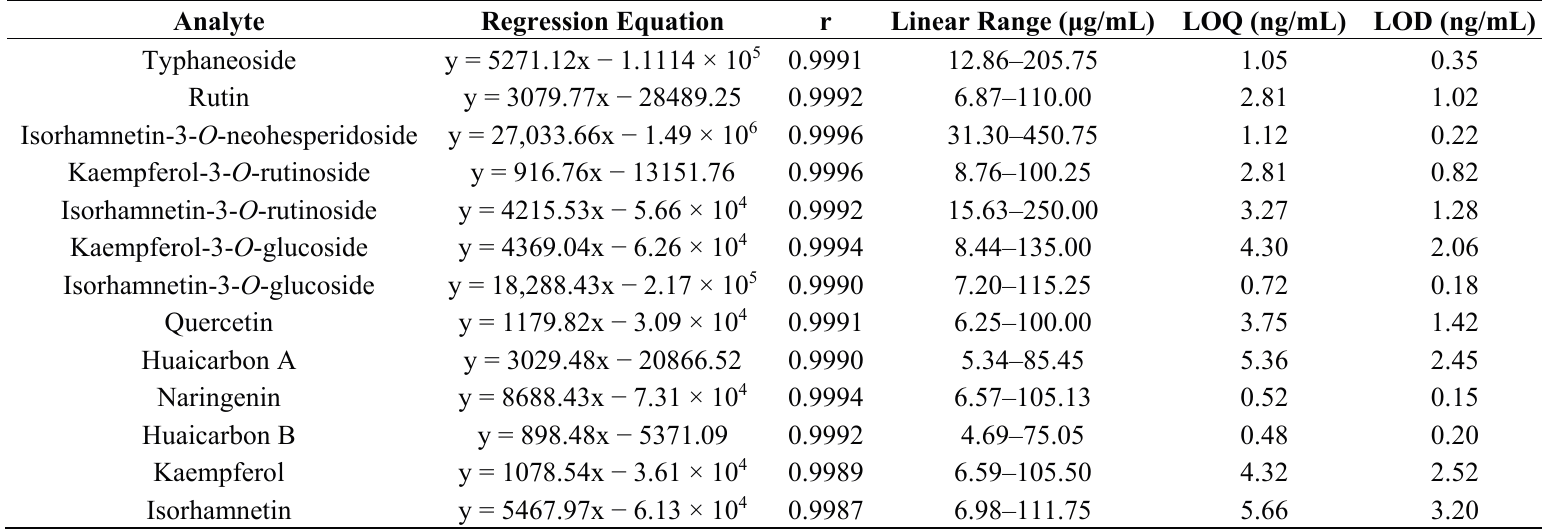
Table 3. Validation data including the regression equations, correlation coefficient (r), linear ranges, limit of detection (LOQ) and lower limit of quantitation (LOD) for the determination of the analytes.